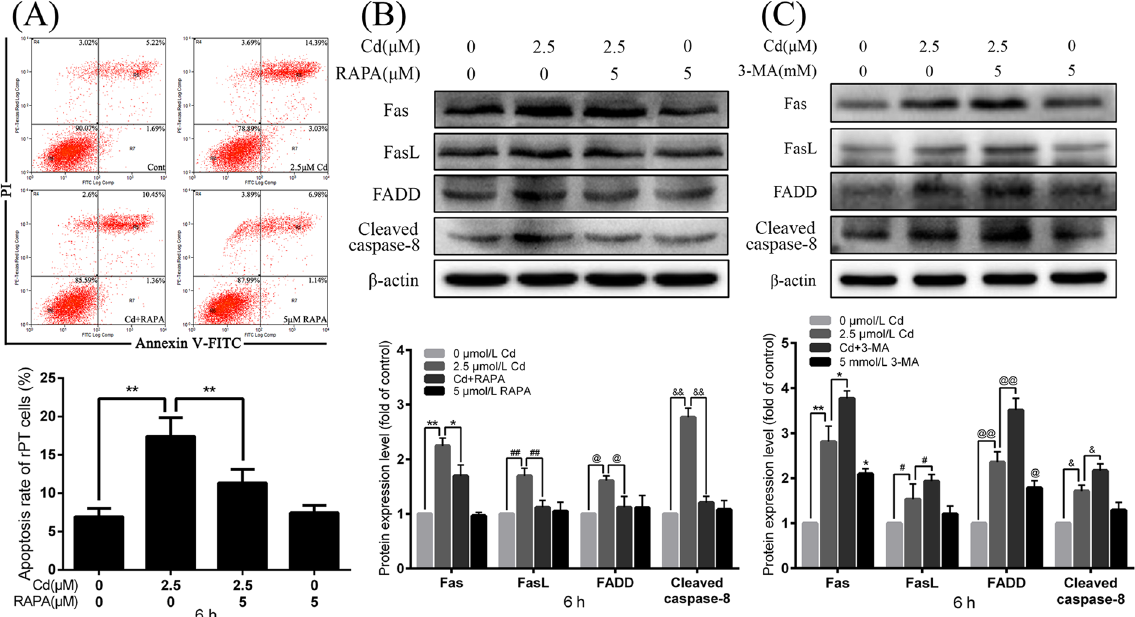
Figure 4. Effects of RAPA and 3-MA on Cd-induced apoptosis and activation of the Fas/FasL signaling pathway. (A) rPT cells were incubated with 2.5 μ M Cd and/or 5 μ M RAPA for 6 h, and apoptosis was assessed by flow cytometry. Data are presented as mean ± SEM of three separate experiments, each one performed in triplicate (n = 9). Fas, FasL, FADD and cleaved caspase-8 protein levels were assessed by western blot analysis after 6 h treatment with Cd and/or RAPA (B) and Cd and/or 3-MA (C) . The quantitative analysis was performed on western blot images of four independent experiments (mean ± SEM, n = 4). * P < 0.05, ** P < 0.01, # P < 0.05, ## P < 0.01, @ P < 0.05, @@ P < 0.01, & P < 0.05 and && P <